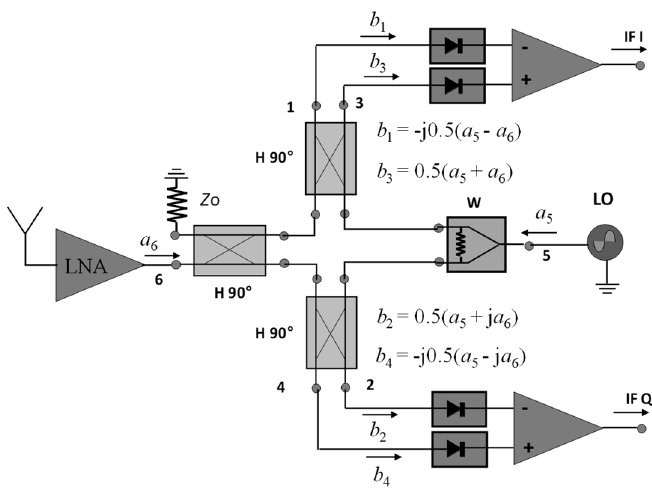
Figure 1. The multi-port interferometer down-converter in a front-end block diagram.